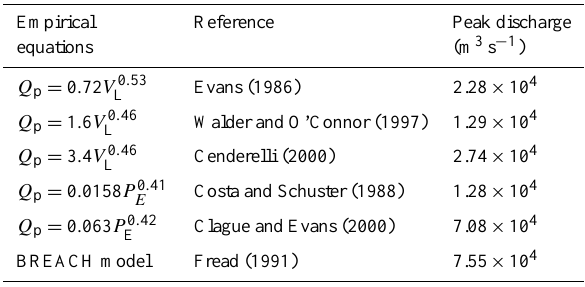
Table 6. Comparison of predictions of the peak discharge of the Tangjiashan landslide dam from empirical equations and the BREACH model.